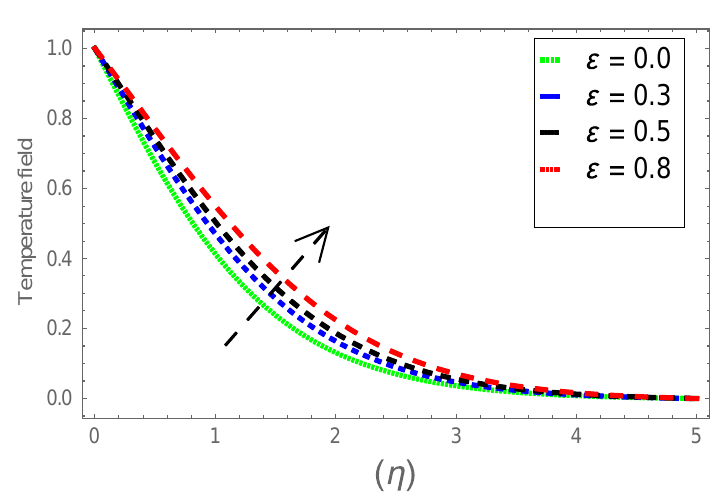
Figure 20. Consequence of ( α ) via φ ( η ) .